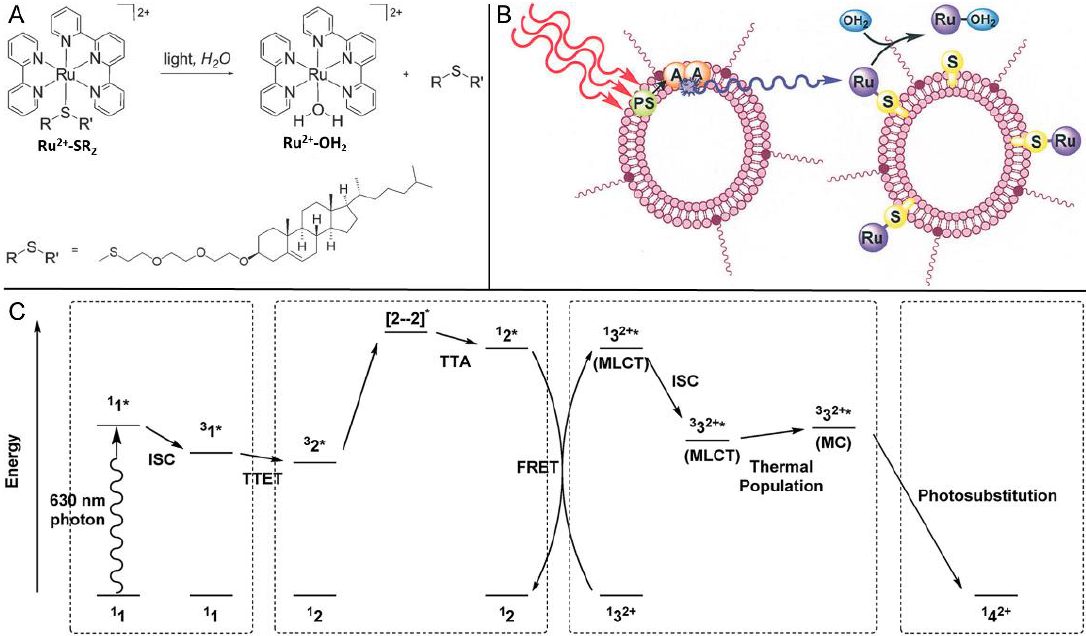
Figure 13. ( A ) Photochemical transformation of Ru 2+ -SRR’ into Ru 2+ -OH 2 by blue light and ( B ) TTA-UC and photoinduced conversion processes in the lipid bilayer (PS and A refer to PdTPTBP photosensitizer and perylene acceptor). Reprinted with permission from ref. [145]. Copyright 2014 Wiley Online Library. ( C ) Schematic Jablonski diagram of the TTA-UC, FRET, and photosubstitution processes in the PEGylated liposomes upon 630 nm light excitation (the numbers 1, 2, 3 and 4 refer to PdTPTBP, perylene, Ru-SR 2 and Ru-OH 2 complexes, respectively). Reprinted with permission from ref. [146]. Copyright The Royal Society of Chemistry